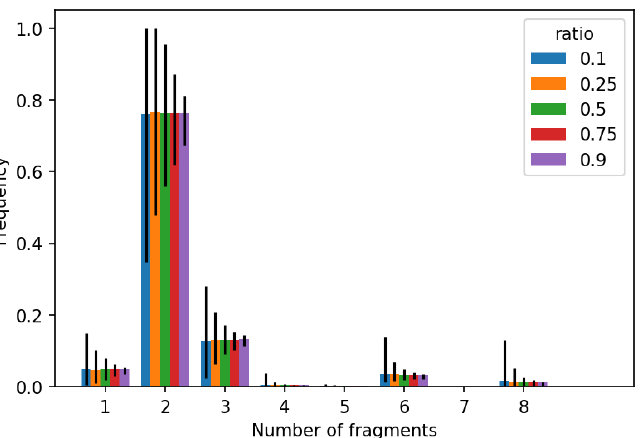
Figure 10. Histogram of the sample mean and the confidence intervals of the fragment count. Each data series represents a different ratio R